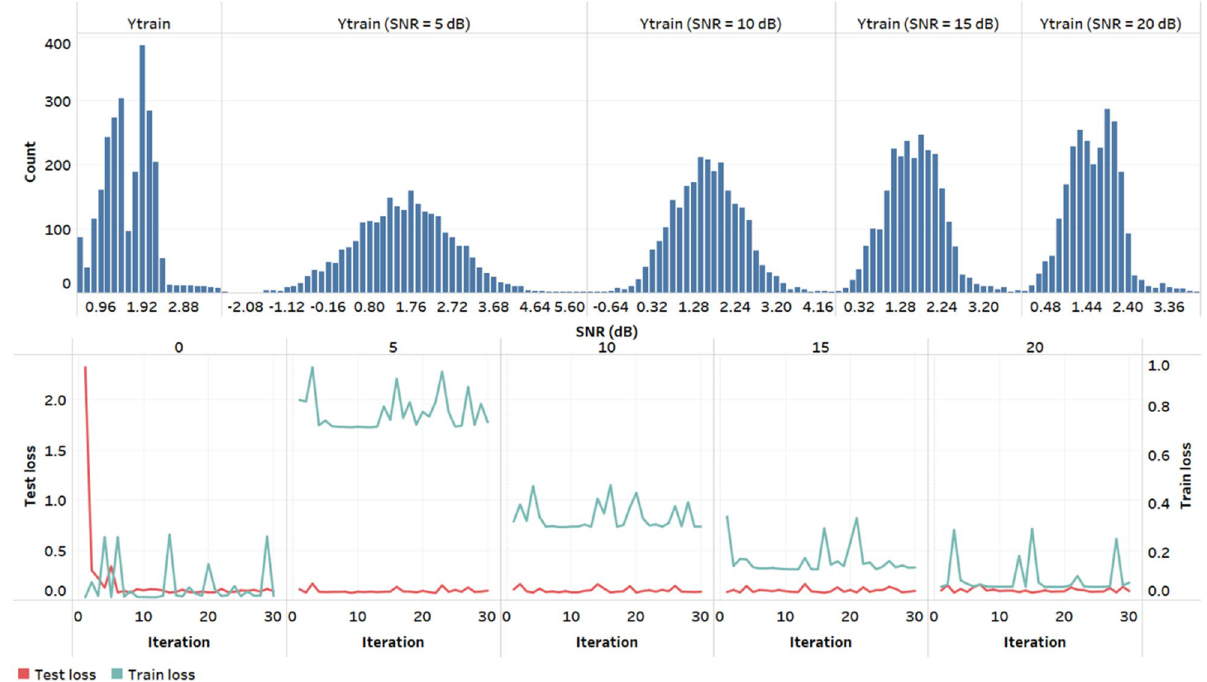
Figure 4. Effect of Gaussian white noise addition on the distribution of Ytrain with statistics and respective loss functions for the decision tree regression algorithm.